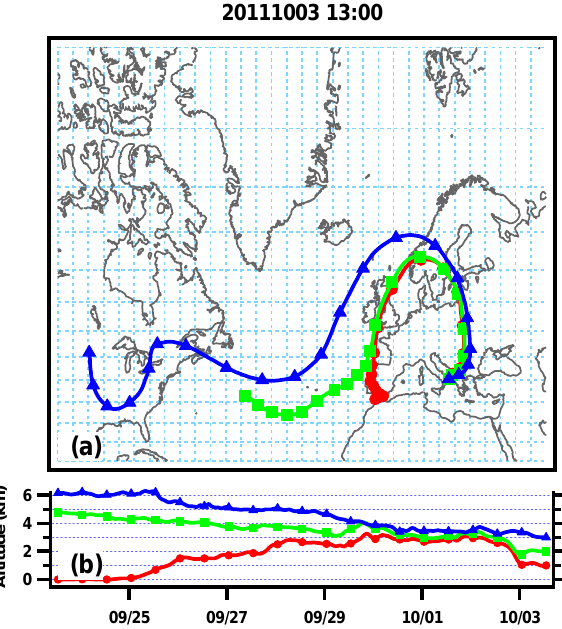
Fig. 12. (a) Pathways estimated for 13:00UTC on 3 October 2011 of the ten day HYSPLIT back trajectories with arrival heights at 1, 2, and 4kma.g.l. (b) Time evolution of the altitude of each back trajectory. 7